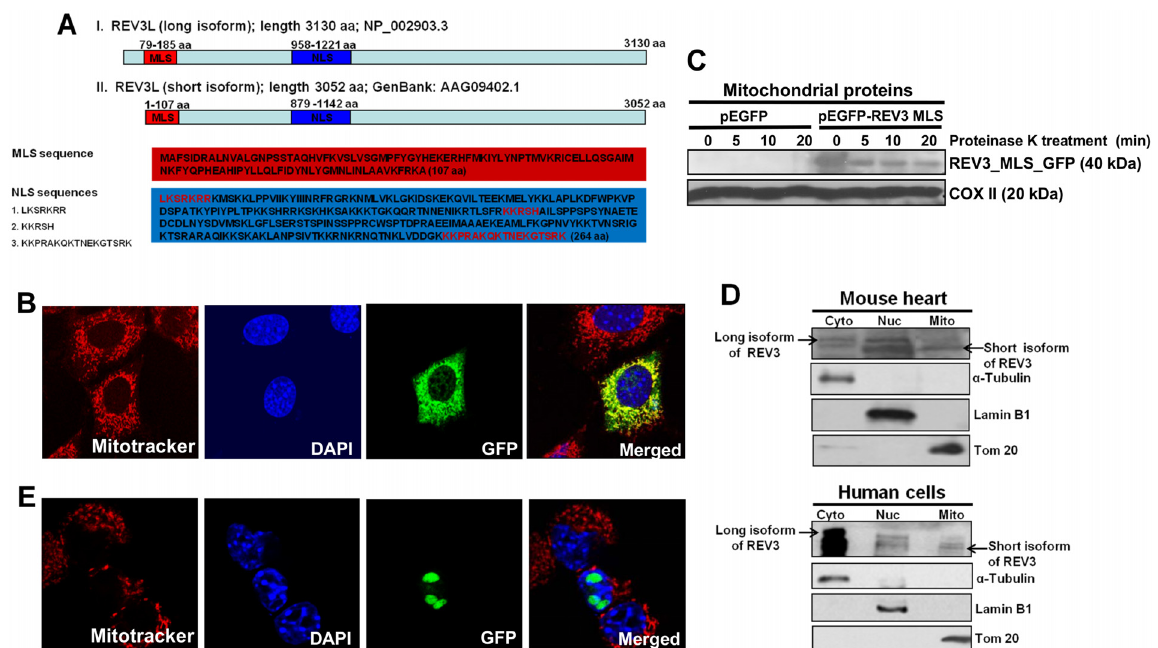
Fig 1. Human REV3L contains a mitochondrial localization signal (MLS) and localizes to mitochondria. ( A ) Schematic drawings of the MLS and NLS in the long and short forms of human REV3L. Amino acid numbers and sequences of MLS and NLS are indicated. ( B ) Fluorescence microscopic pictures showing the localization of Rev3MLS attached GFP protein in mitochondria of NIH3T3 cells. ( C ) Western blot analysis showing mitochondrial localization of Rev3MLS attached GFP protein and mitochondria-encoded COX II protein using protein extract from proteinase K-treated mitochondria. ( D ) Western blot analyses of cytoplasmic (cyto), nuclear (nuc), and mitochondrial (mito) protein fractions from mouse heart and human breast epithelial cell line MDA-MB-231 showing the localization of long and short isoforms of REV3 protein in different cellular compartments. ( E ) Fluorescence microscopic pictures showing the localization of Rev3NLS attached GFP protein in the nucleus of NIH3T3